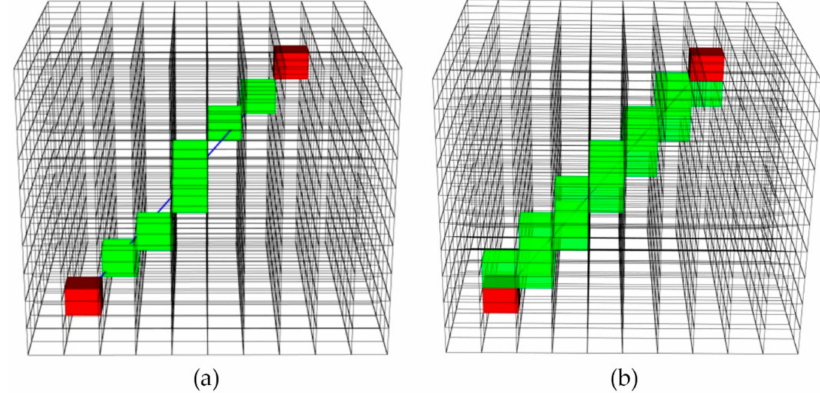
Figure 5. Voxelizing the line (blue) between the initial and target voxels (red) using di ff erent methods. Green voxels are sampled ( a ) by common line rasterization methods and ( b ) by a ray tracing algorithm proposed by Amanatides and Woo